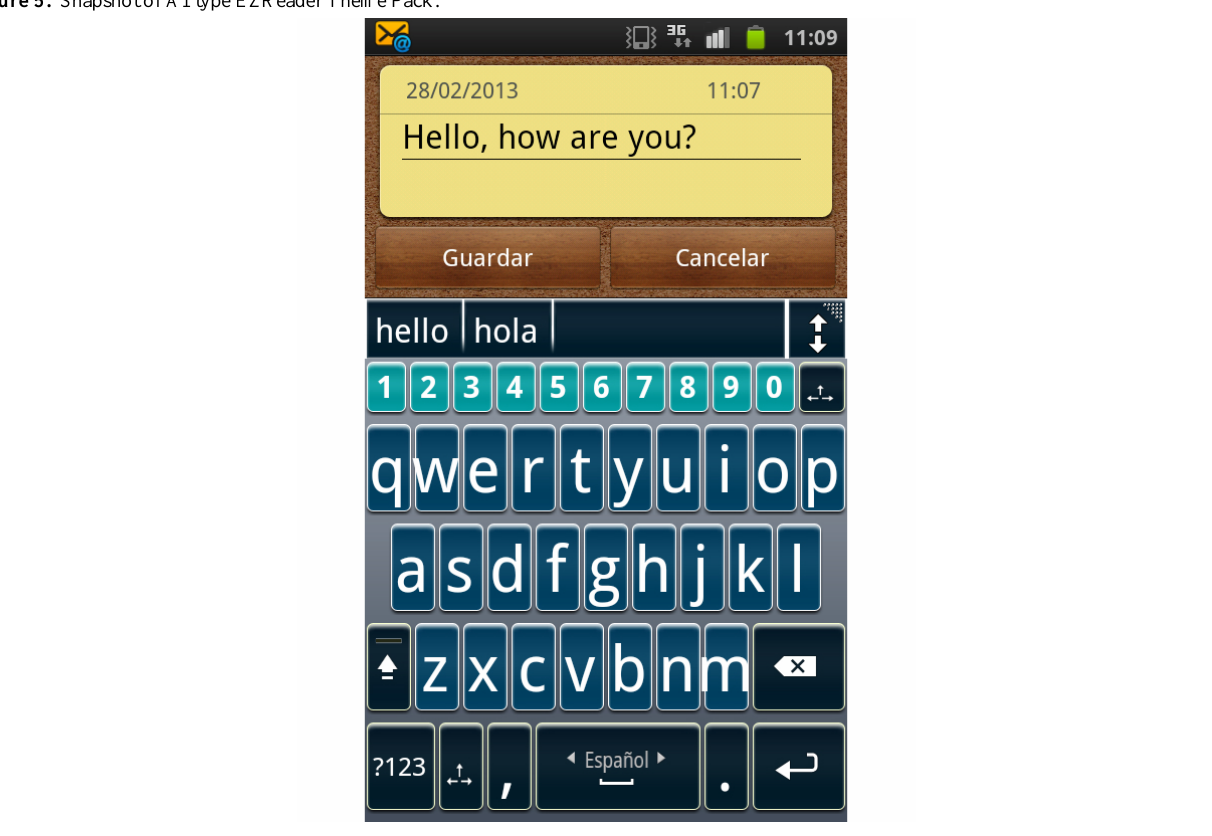
Figure 5. Snapshot of AI type EZReader Theme